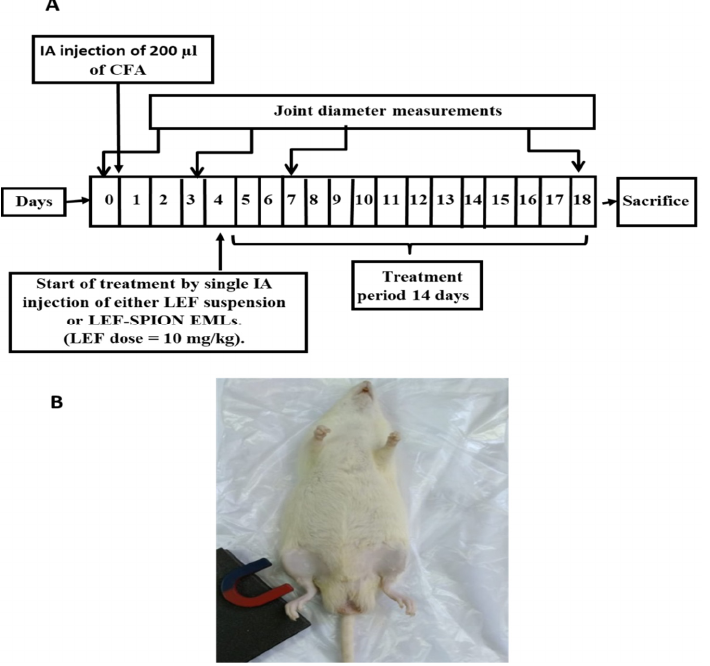
Figure 1. ( A ) Schematic representation of experimental design; ( B ) application of magnetic field following dose administration. Measurement of Joint Diameter